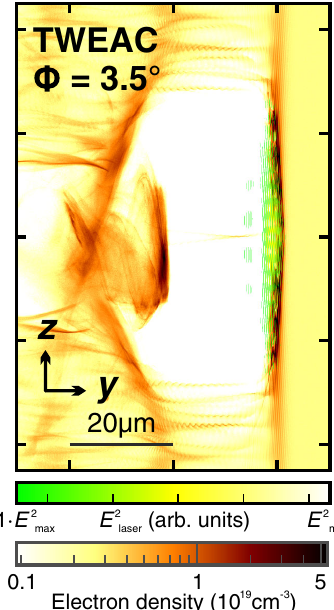
FIG. 7. The TWEAC cavity after shock injection using orthogonally polarized laser pulses at 3.5° incidence angle. Compared to the 5°-TWEAC case, this scenario was optimized to reduce the injected charge while improving energy efficiency (see Table I), with laser-electron beam-energy efficiency reaching 47%. The injected 1.8-nC electron bunch features dimensions of 2 . 2 μ m × 4 . 8 μ m × 13 μ m